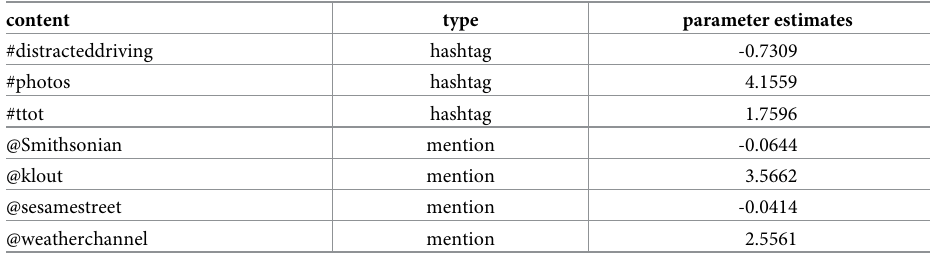
Table 7. Significant attributes selected for the Twitter